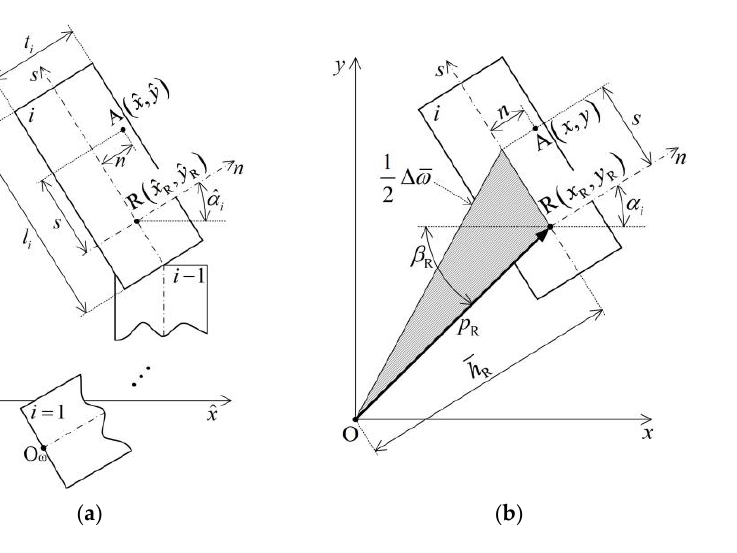
Figure 2. Arbitrary rectangle geometry: ( a ) general coordinates, ( b ) contour warping function, and ( c ) thickness warping function.